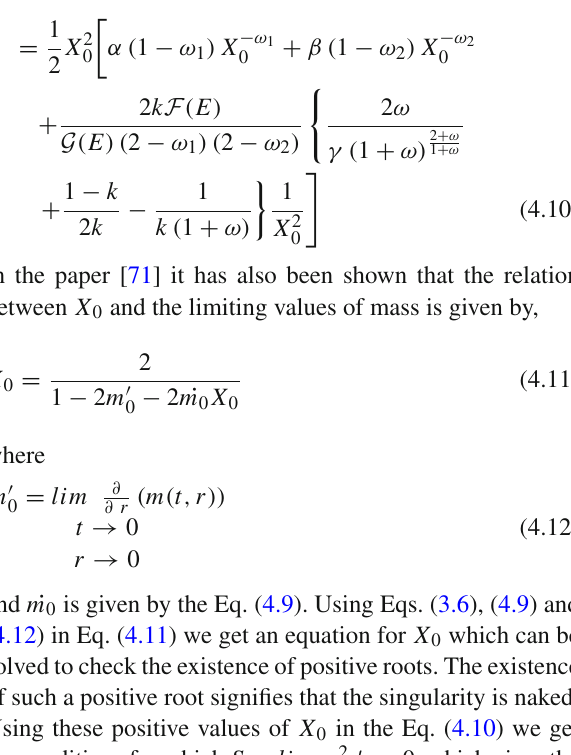
The real positive root of the above equation describes the radius of the event horizon. Figure 4 presents the typical behavior of f ( t , r ) in terms of r for different values of the parameter k . Here we have used the values of the other parameters such as E 1 , E P , n , F , V 0 , f 2 ( t ), f 3 ( t ), f 4 ( t ) as described in Sect. 4. Figure 4a shows the horizon structure of the Vaidya spacetime in BD gravity’s rainbow and in Fig. 4b we have shown the zoomed range of outer horizon obtained from Fig. 4a.These two figures yield r h ≈ 1 for the selected value of the parameters. In [73] a time dependent geometry in massive theory of gravity has been analyzed and thermo- dynamical aspect of such geometry has been